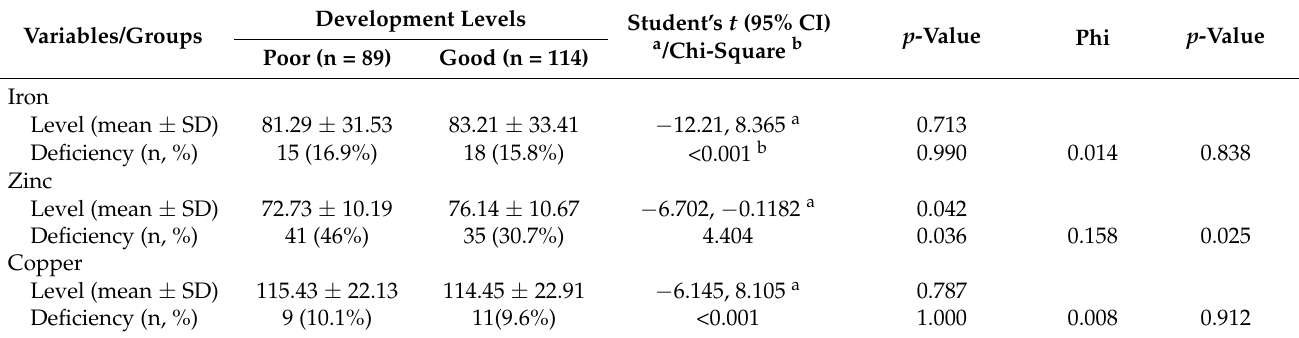
Table 4. Correlation of trace element levels and deficiency with development